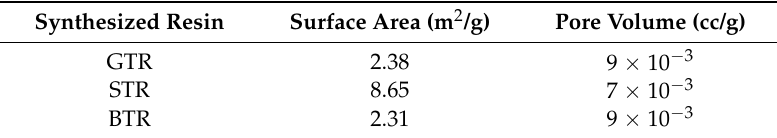
Table 1. BET specific surface areas and pore volume for the resins. Synthesized